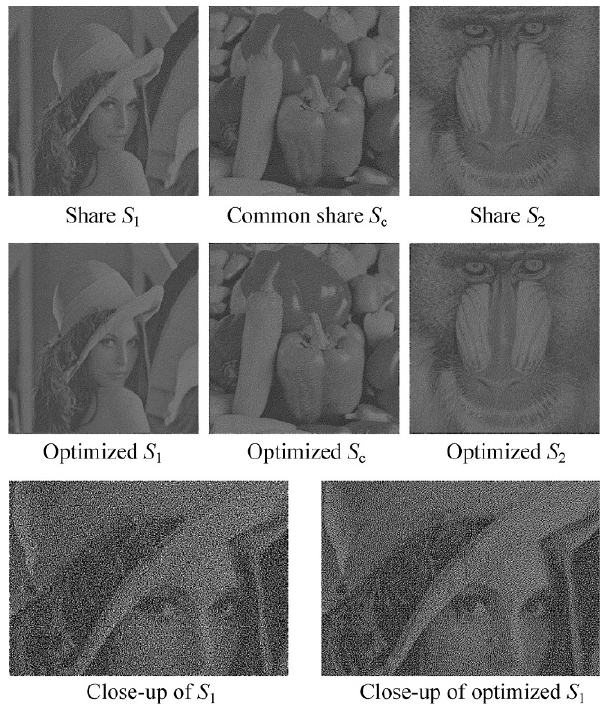
Fig. 3 Results of our proposed EVCS. Input images are 512 × 512 pixels while outputs are 1024 × 1024 pixels. Top: unoptimized results. Middle: optimized results. Bottom: close-ups of unoptimized and optimized S 1 .